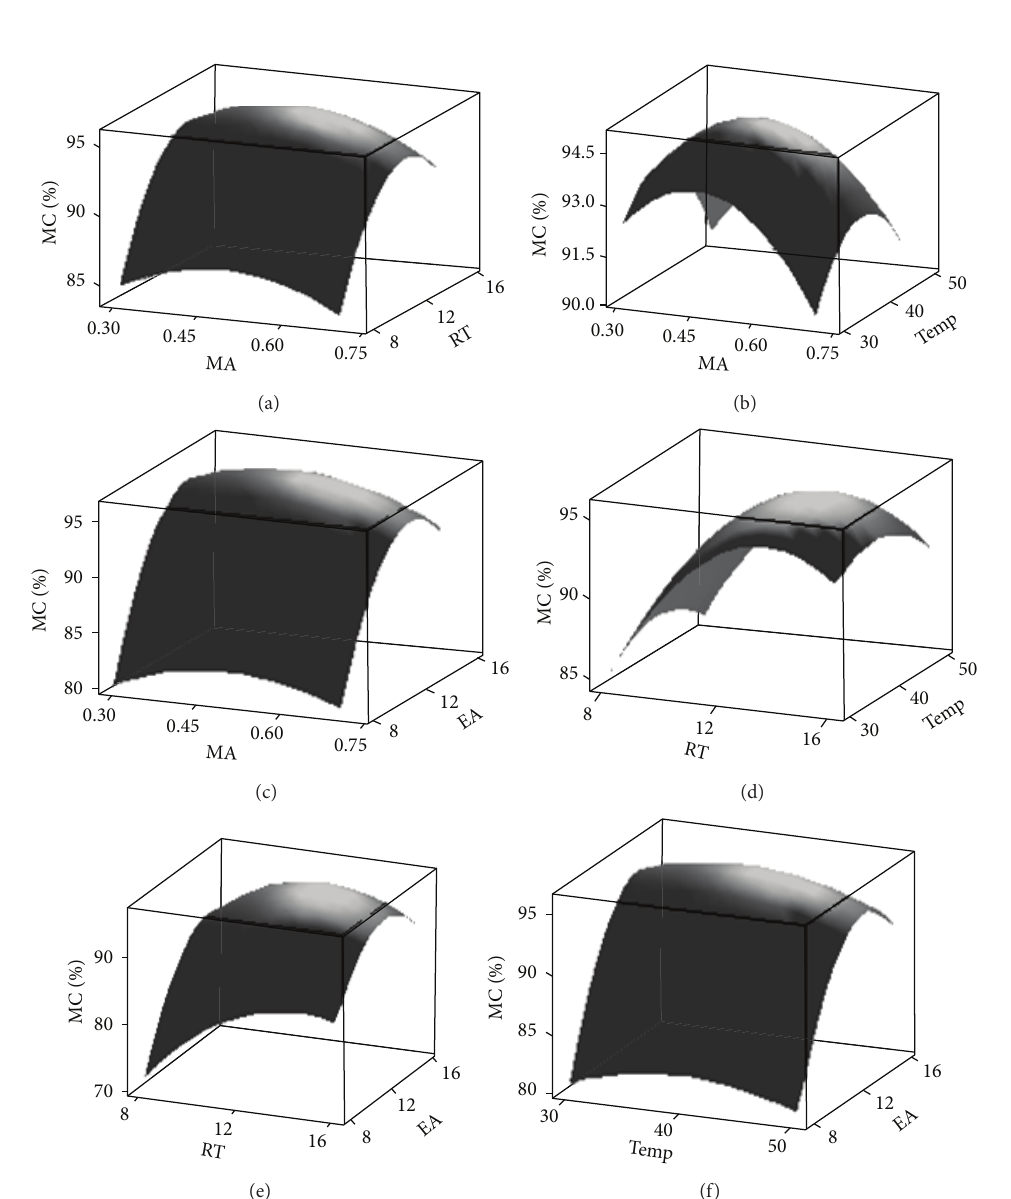
Figure 1: Surface plots of molar conversion (%) with: (a) alcohol molarity and reaction time, (b) alcohol molarity and temperature, (c) alcohol molarity and enzyme activity, (d) reaction time and temperature, (e) reaction time and enzyme activity, (f) temperature and enzyme